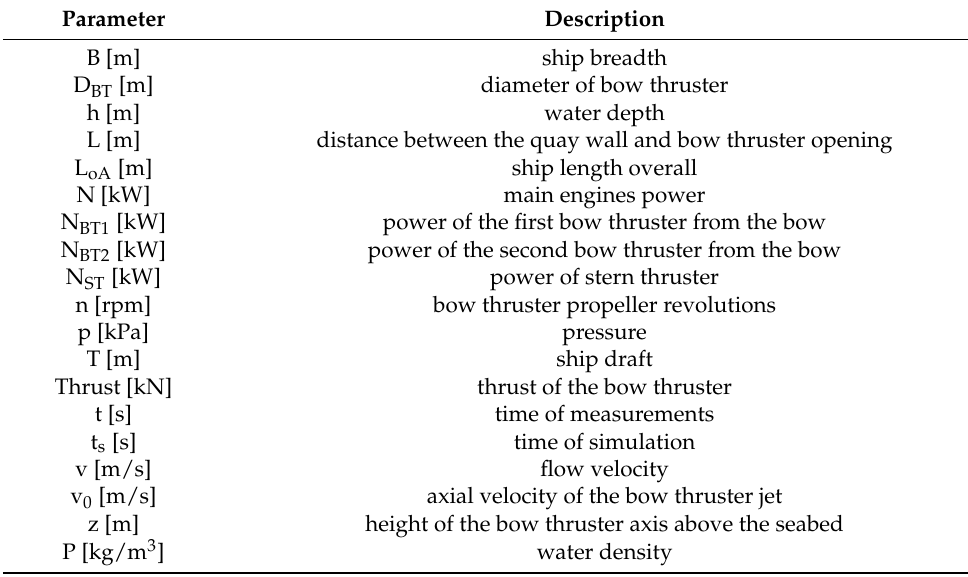
Table 1. List of variables used in the